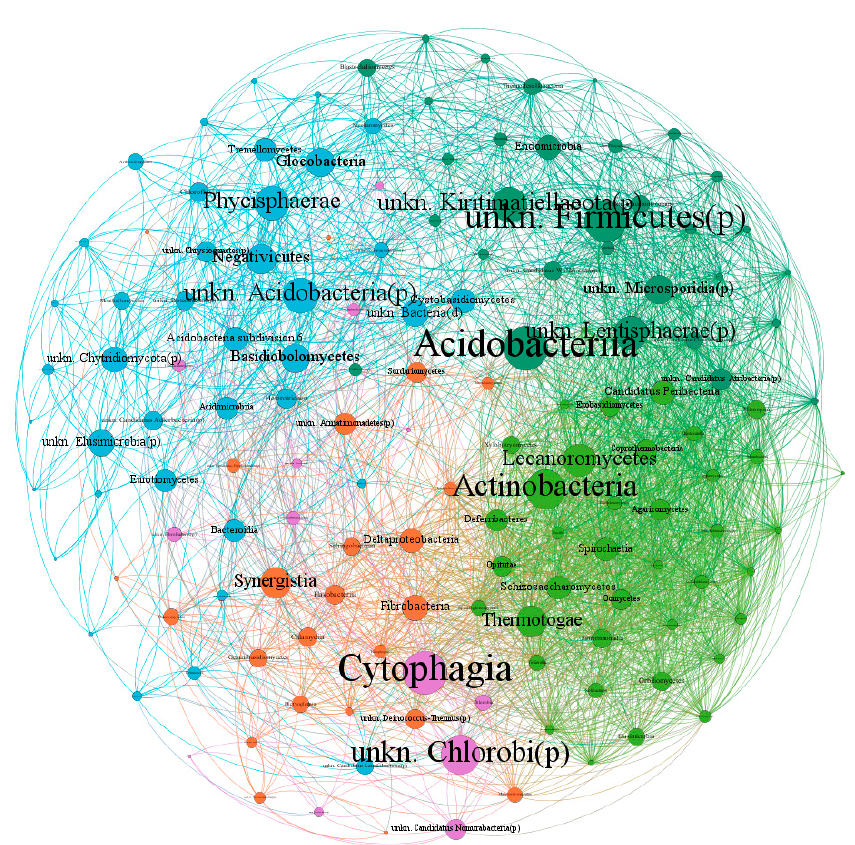
Figure 5. Network analysis revealing the co-occurrence patterns between OTUs (class level). The nodes were colored according to modularity class. The connection between nodes represents a strong (Spearman’s correlation coefficient ρ > 0.5) and significant ( p -Value < 0.05) correlation. The size of each node is proportional to the proximity of a node to all other nodes in the network (that is, Betweenness Centrality).